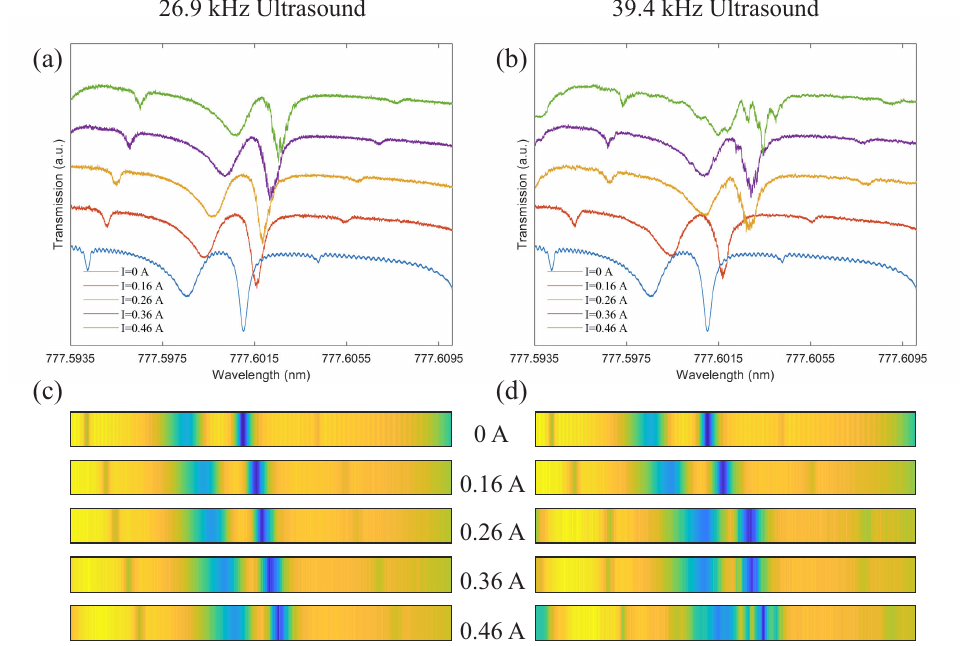
Figure 5. Variation trend of the resonance of mode ii with ultrasound. ( a ) The response of mode ii to the 26.9 kHz ultrasound. ( b ) The response of mode ii to the 39.4 kHz ultrasound. ( c ) Optical barcode corresponding to ( a ). ( d ) Optical barcode corresponding to ( b